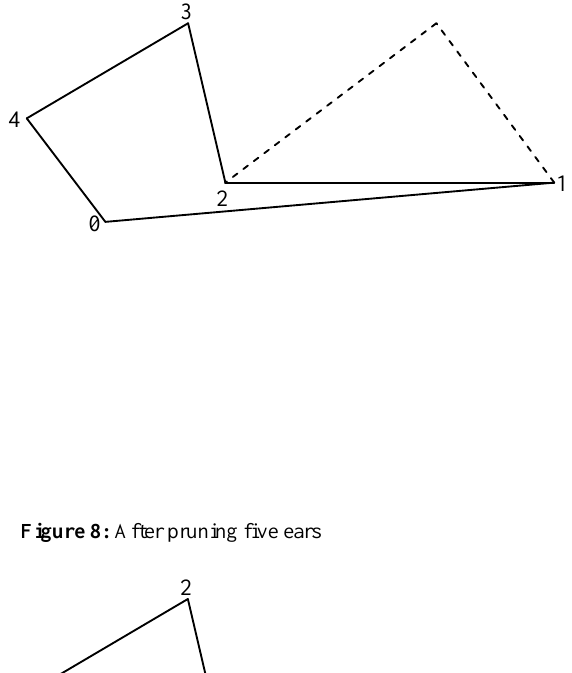
Figure 8: After pruning five ears